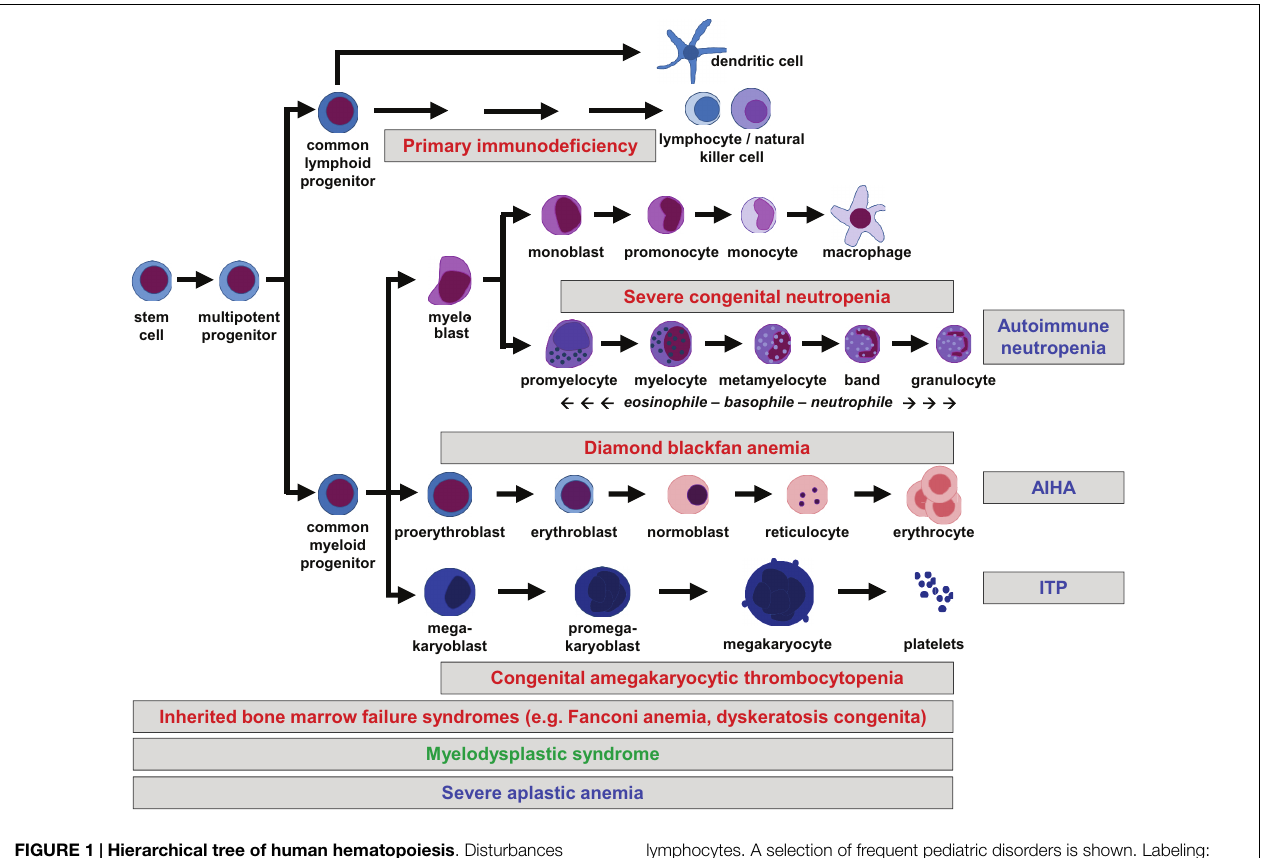
FIGURE 1 | Hierarchical tree of human hematopoiesis . Disturbances leading to cytopenias can affect single or multiple lineages and be caused by cell-intrinsic or extrinsic mechanisms. Intrinsic defects are caused by inherited or acquired mutations, while extrinsic defects can be caused by autoreactive